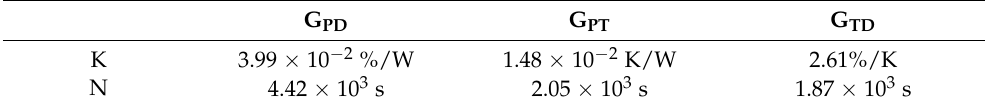
Table 2. Parameters of the transfer function models from Figure